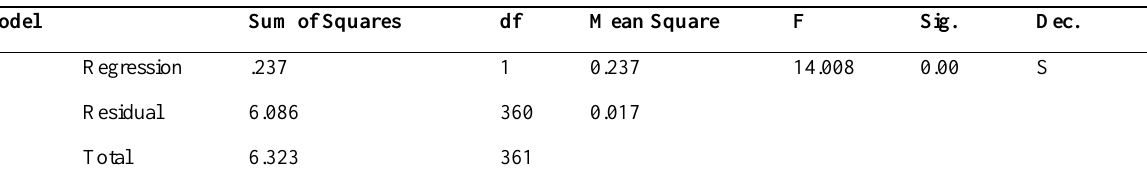
in Cross River State, Nigeria